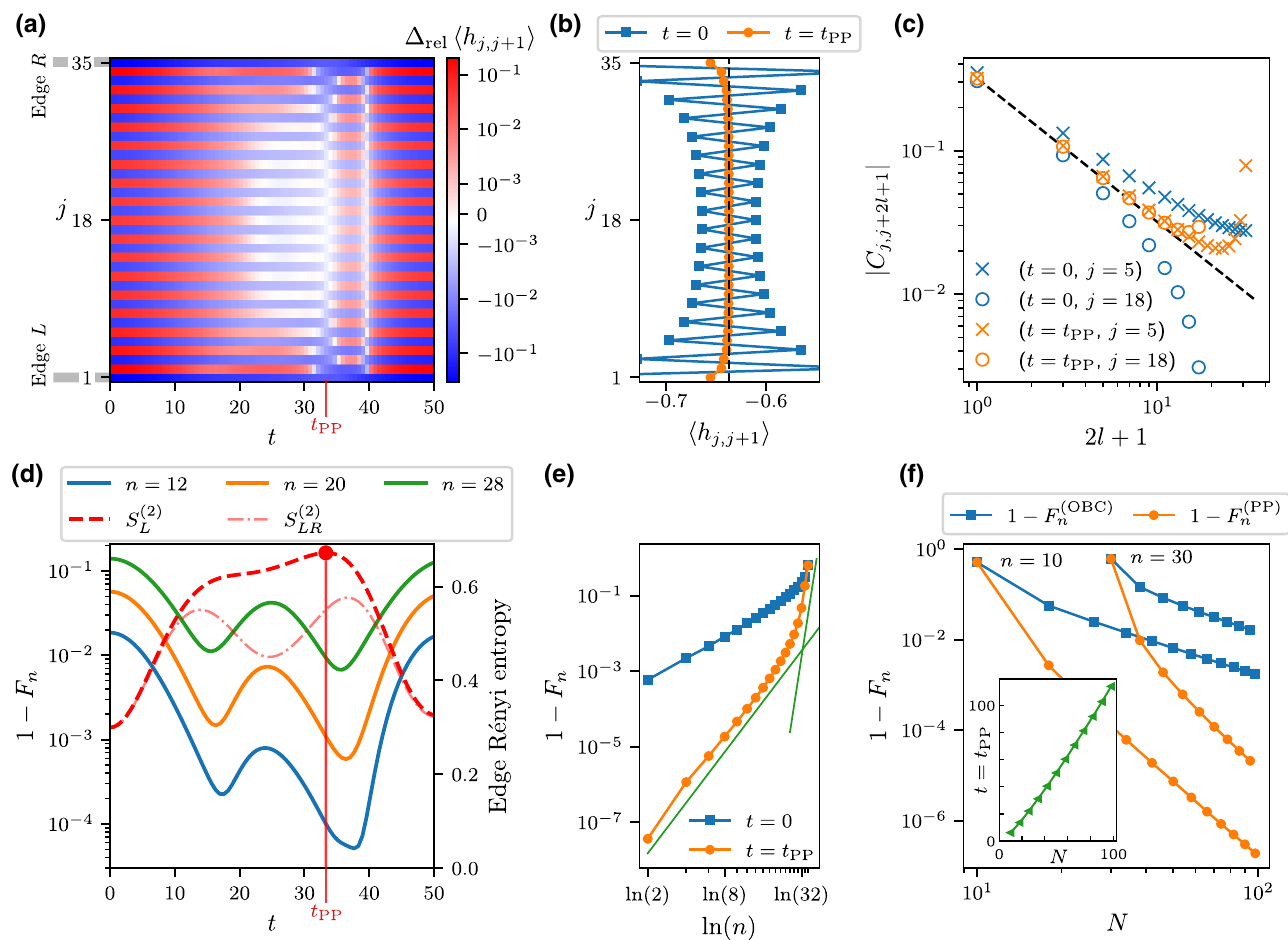
FIG. 3. Purification preparation for free fermions [see Eq. (7)] on a one-dimensional lattice with N = 36 sites. (a) Relative deviation of the energy density [Eq. (9)] during the PP. The gray boxes indicate the edge subsystems used to measure the second Rényi entropies and S ( 2 ) , plotted in (d), of the edge L and both edges L and R , respectively. Each edge consists of two neighboring qubits. (b) S ( 2 ) L LR Energy density and (c) two-point correlation function [Eq. (8)] at times t = 0 and t = t PP . The black dashed lines correspond to the and S ( 2 ) of the edges indicated infinite GS. (d) Infidelity [Eq. (10)] for several bulk sizes n (left axis) and the second Rényi entropies S ( 2 ) L LR in (a) (right axis). The red vertical line indicates the time t PP at which S ( 2 ) reaches its maximum and the PP protocol stops. (e) Bulk L infidelity [Eq. (10)] versus the bulk size n in the initial state ( t = 0) and at time t PP . The green lines indicate two distinct power laws ∝ n k (see text). (f) Bulk infidelities 1 − F ( OBC ) in the OBC GS and 1 − F ( PP ) in the PP state versus the system size N for the two n n of the two bulk sizes n = 10 and n = 30. The inset shows the time t PP obtained from the maximum of the second Rényi entropy S ( 2 ) L neighboring edge